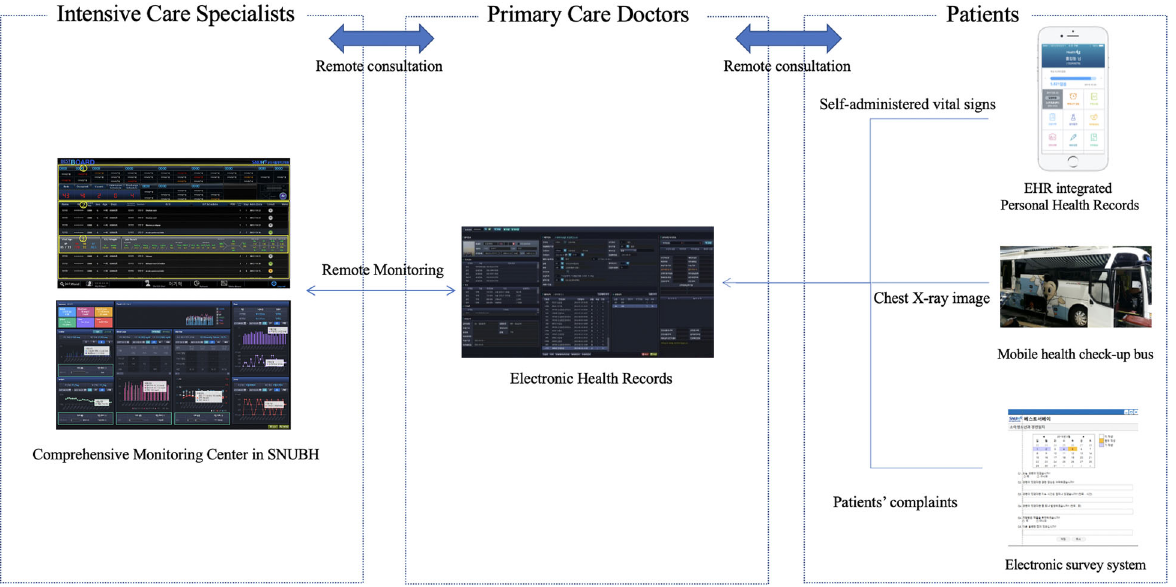
Fig. 3 The overall architecture of telemedicine for community treatment center supported by SNUBH. Intensivists and primary care doctors can monitor patients in the community treatment center through telemedicine. Figure derived from Seoul National University Bundang Hospital.